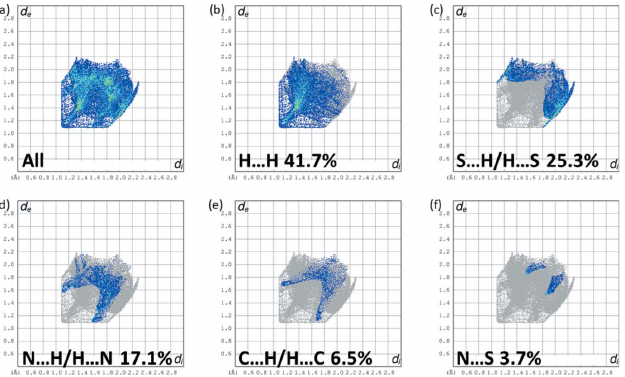
Figure 12 The full two-dimensional fingerprint plot for L1 , and fingerprint plots delineated into H (cid:2)(cid:2)(cid:2) H, S (cid:2)(cid:2)(cid:2) H/H (cid:2)(cid:2)(cid:2) S, N (cid:2)(cid:2)(cid:2) H/H (cid:2)(cid:2)(cid:2) N, C (cid:2)(cid:2)(cid:2) H/H (cid:2)(cid:2)(cid:2) C, and N (cid:2)(cid:2)(cid:2) S